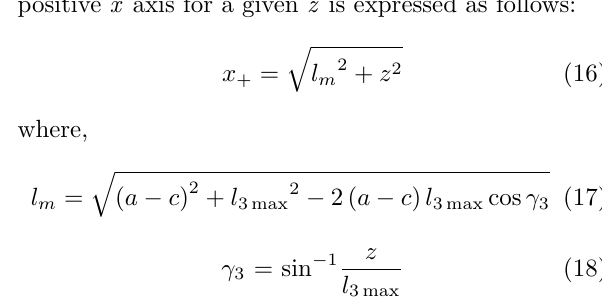
Similarly, the movement of distance of the MP along the negative x axis could be calculated by above